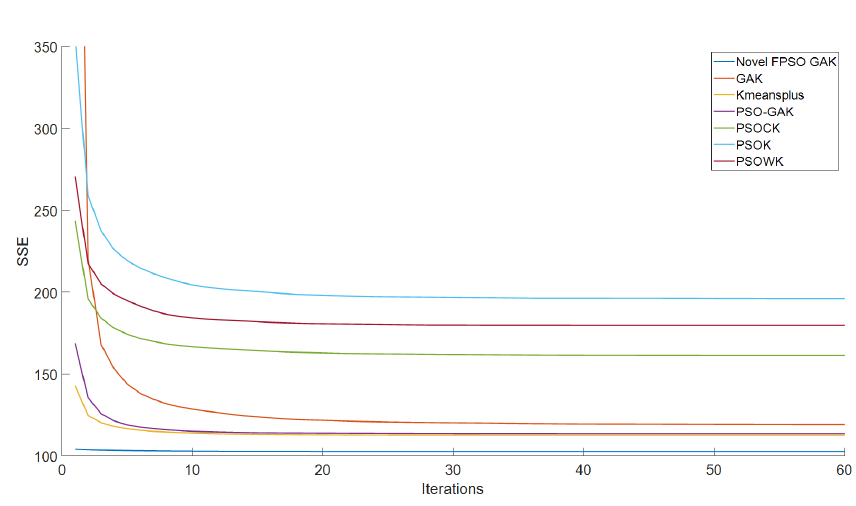
Figure 11. The SSE convergence curve of taxi GPS dataset from Chongqing (China).